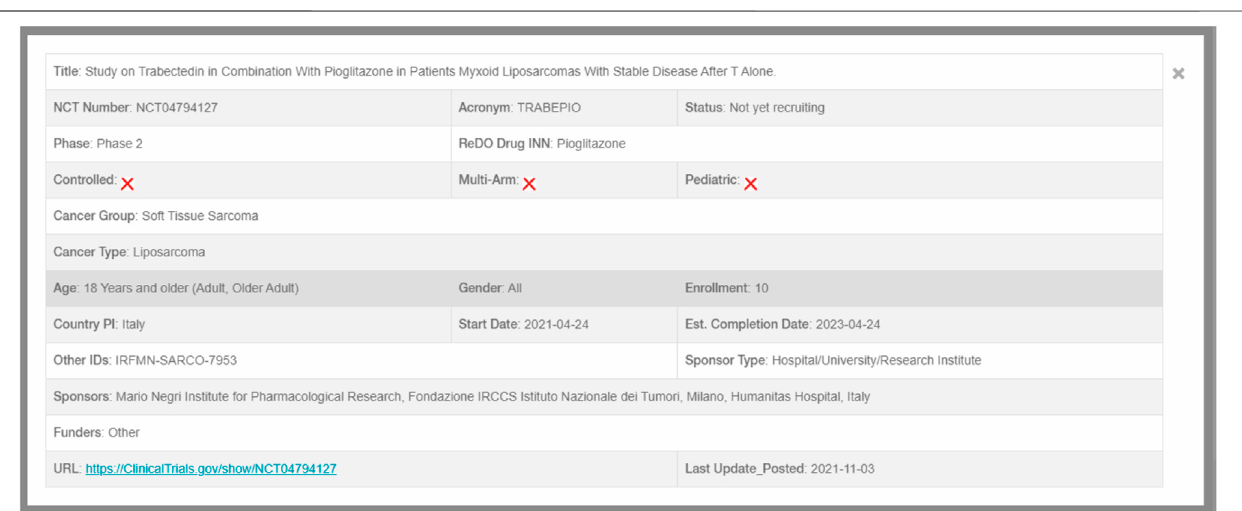
(cid:129) Phase — Phase 1 to Phase 4, Not applicable (N/A), Other (cid:129) Setting — For Phase 3 trials only: Primary/Main Curative, Neo- adjuvant/Window, Adjuvant/Maintenance, Perioperative,